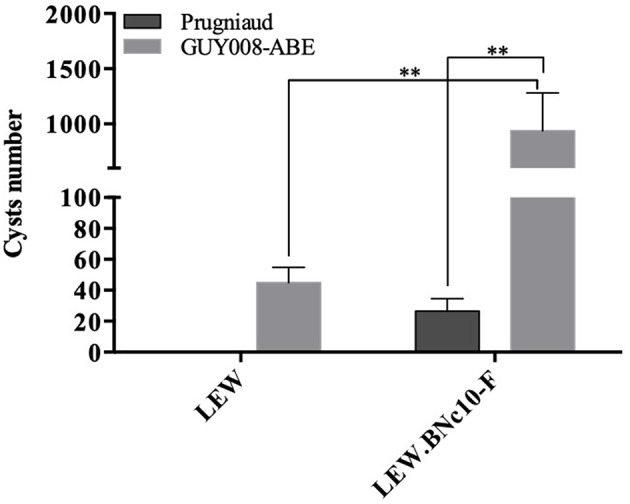
Influence of Toxo1 on Guiana toxoplasmosis infection outcome. Rats were intraperitoneally infected with 107 tachyzoites of type II Prugniaud (n = 6) or GUY008-ABE (n = 6) strains. Animals were sacrificed 2 months post-infection and presence of cerebral cysts assessed. Cyst values were submitted to 2-way ANOVA analysis followed by a Tukey's multiple comparisons test (**p < 0.005).